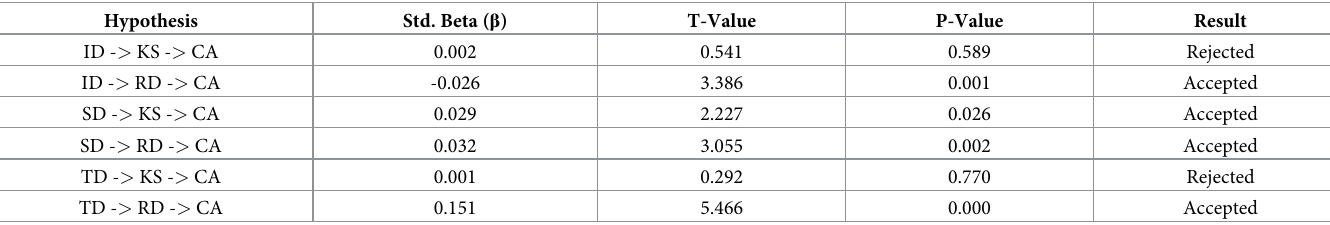
Table 7. Test of hypothesis (Indirect/Mediation